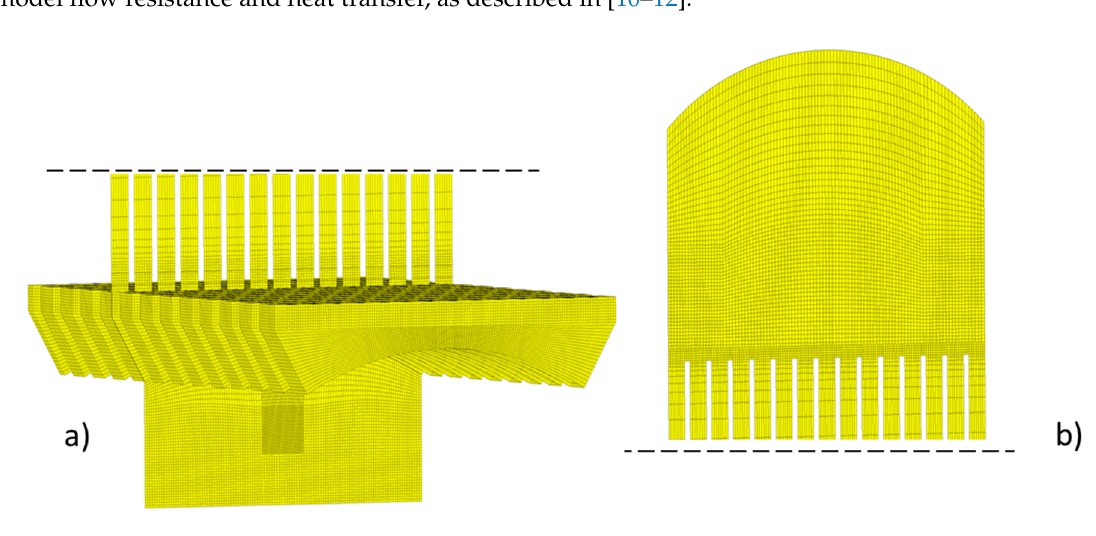
Figure 5. Mesh section of the RC3 regenerative chamber—( a ) bottom, ( b ) top.